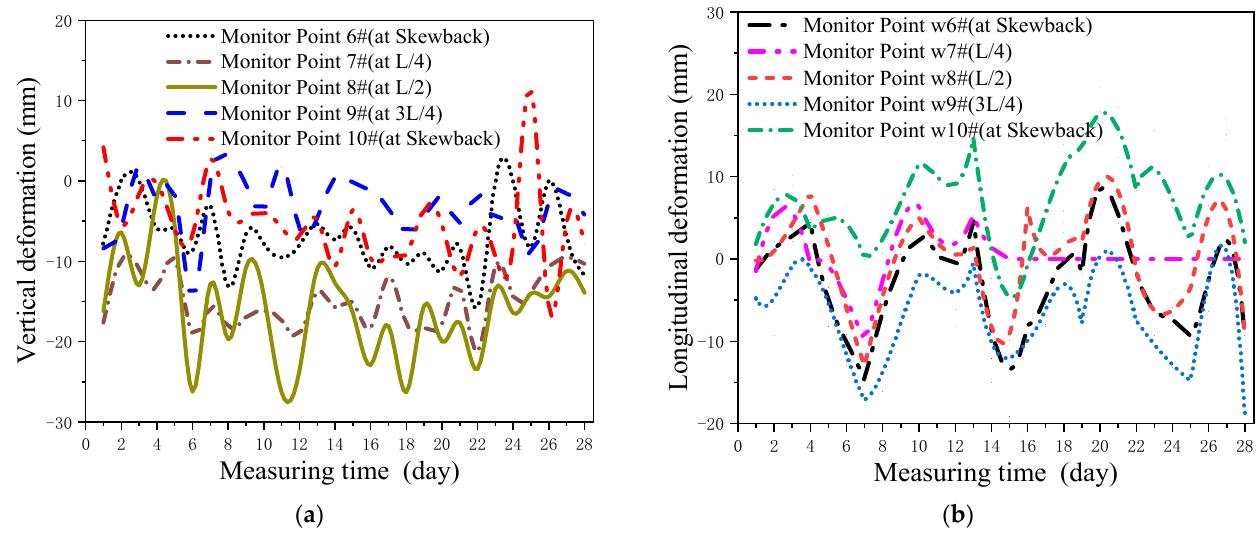
Figure 9. Monitoring results of deformation of arch ribs: ( a ) Monitoring result of vertical defor- mation of arch ribs; ( b ) Monitoring result of longitudinal deformation of arch ribs.